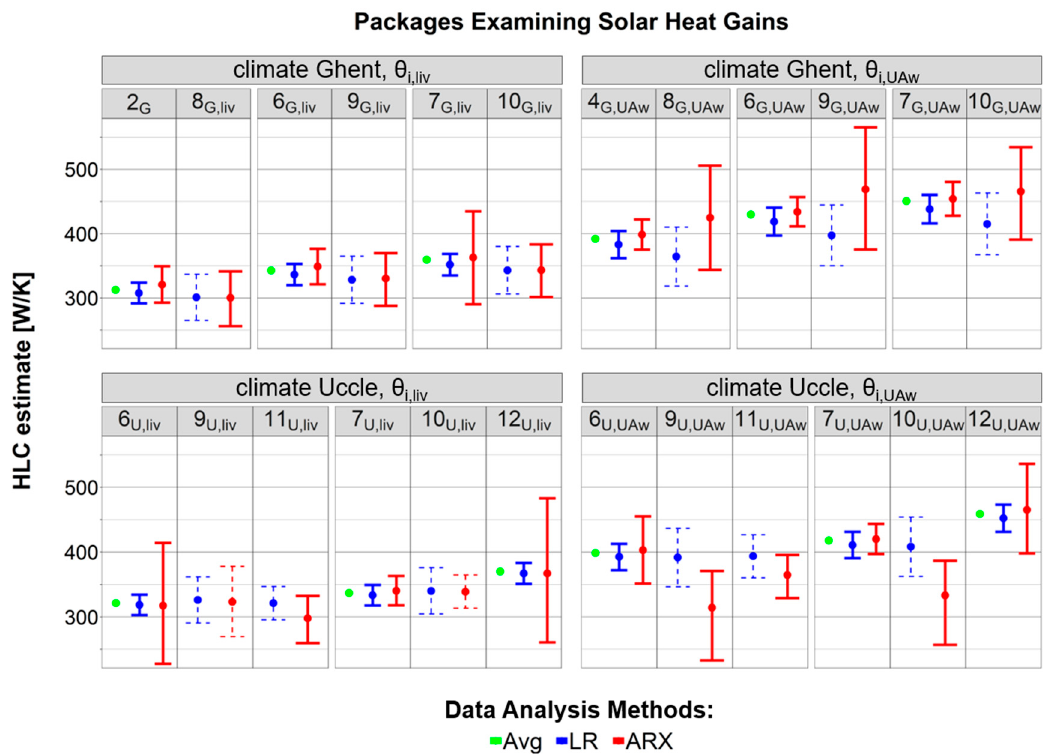
Figure 8. HLC estimates obtained by applying the Average method (Avg), Linear Regression (LR), and an ARX model on the data packages investigating the influence of the incorporation and representation of the solar gains. The dots indicate the mean estimates, and the whiskers represent the 95% confidence intervals. The outcome of models that are considered invalid are shown dashed.